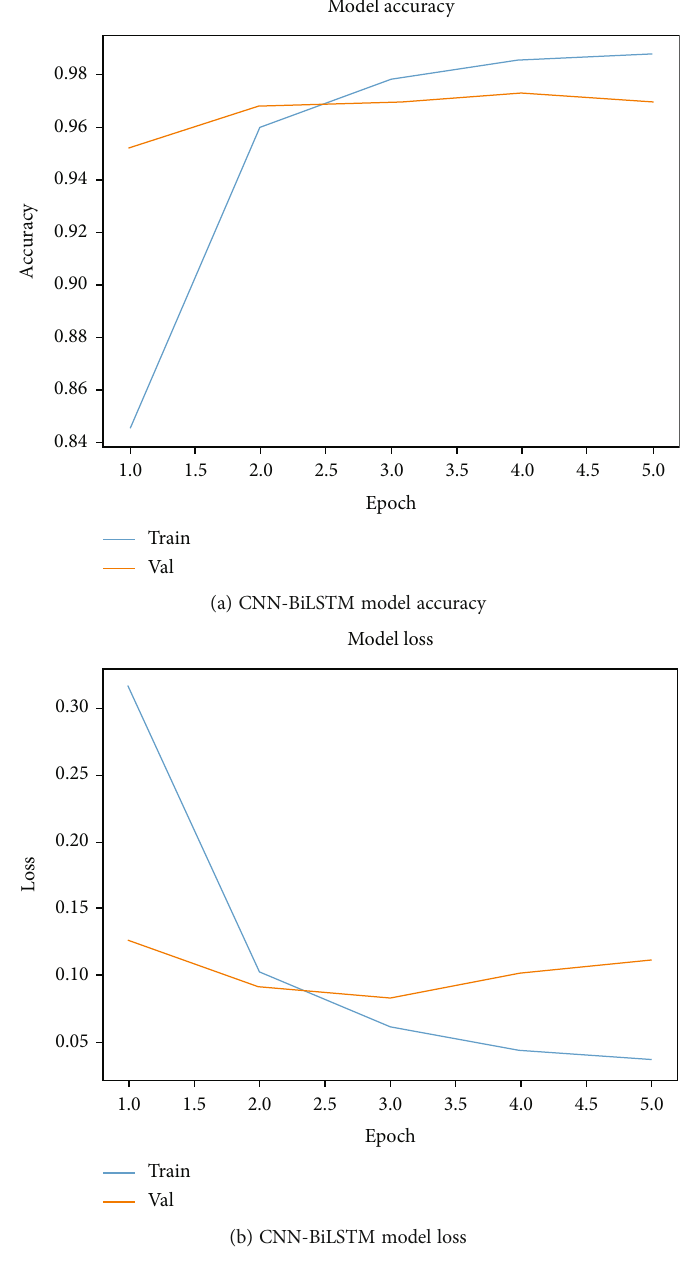
Figure 5: Performance plot of the CNN-BiLSTM model using text